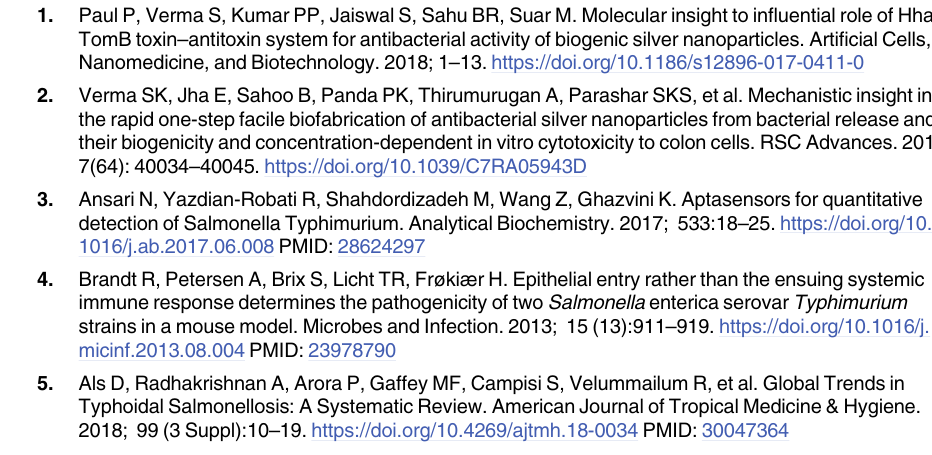
S1 Fig. The DLS result of CdTe